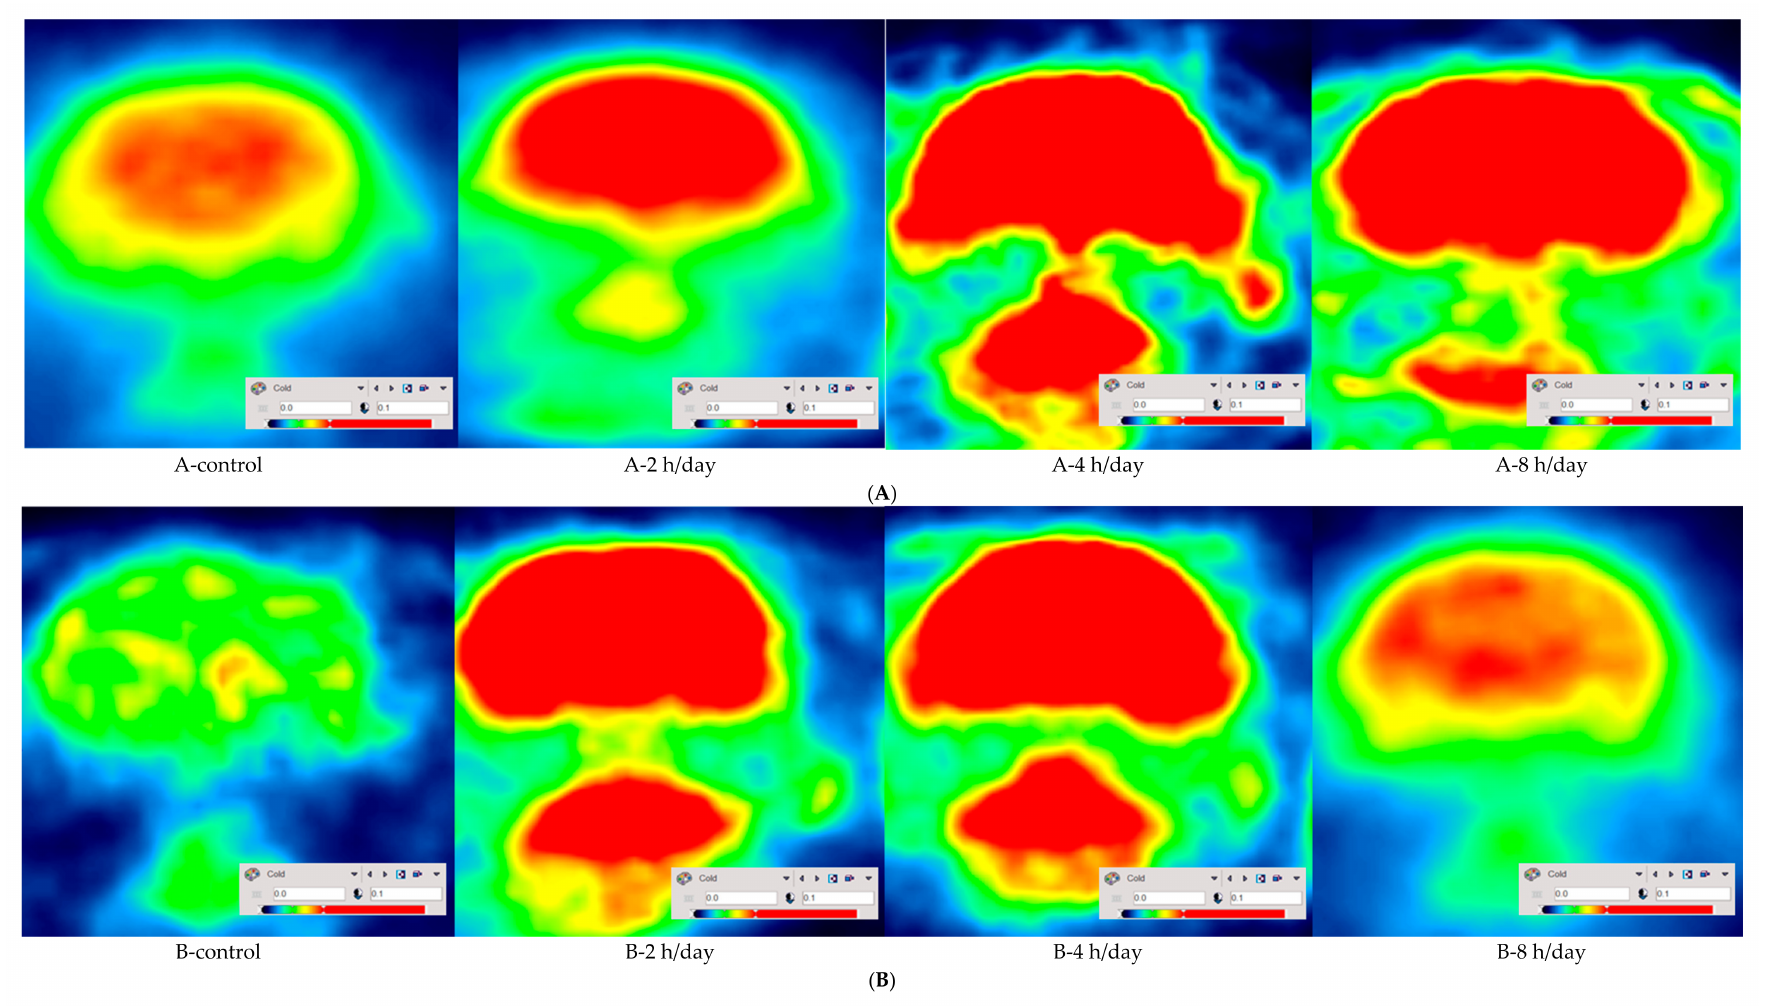
Figure 4. Micro PET-CT imaging after five days hypoxic exposure and at 5 days rest after hypoxia at the level of hippocampus. Activity of brain metabolism increased in 2, 4 and 8 h per day group compared with the control group after five days hypoxic exposure ( A ), however, Activity of brain metabolism increased in 2 and 4 h per day group compared with the control group at 5 days rest after hypoxia ( B